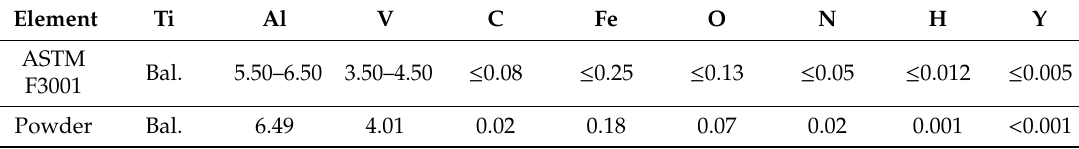
Table 1. The chemical composition (in wt %) of Ti-6Al-4V